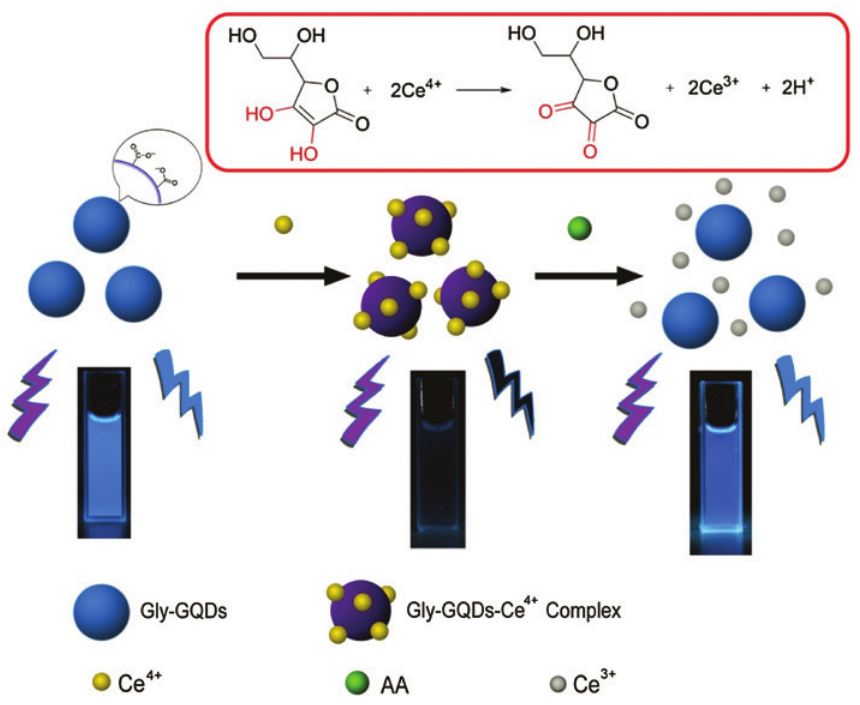
Figure 18: “Off-on” fluorescence system of GLY-GQDs-Ce 4+ -AA (reprinted/reproduced with the permission of Ref. [43], copyright 2017, Else- vier